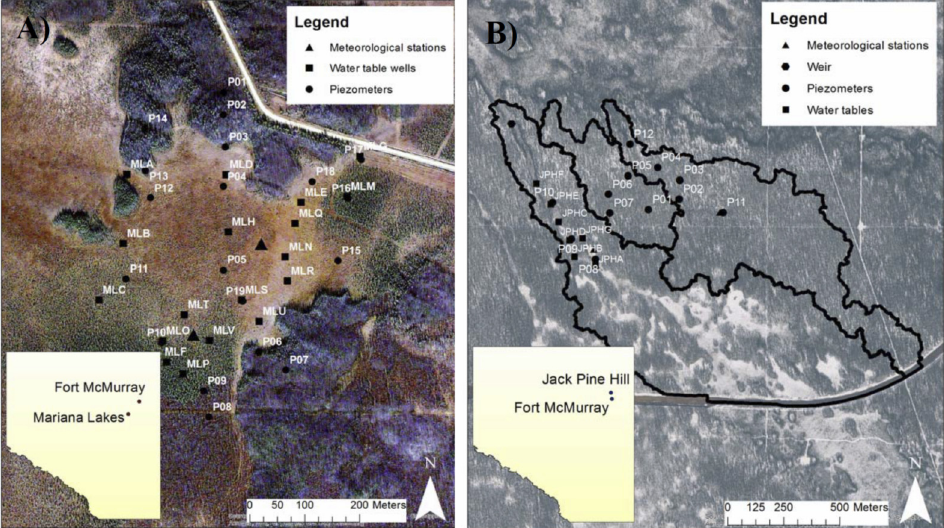
Figure 2. Location of instrumentation installed at ( A ) ML and ( B ) JPH. Note the scale differences in ( A ) and ( B ). Colours at ML depict uplands (purple), bogs (green), and fens (brown). Outlines at JPH depict delineated drainage areas including the rich fen (unit located to the southwest) and upland terrain units.